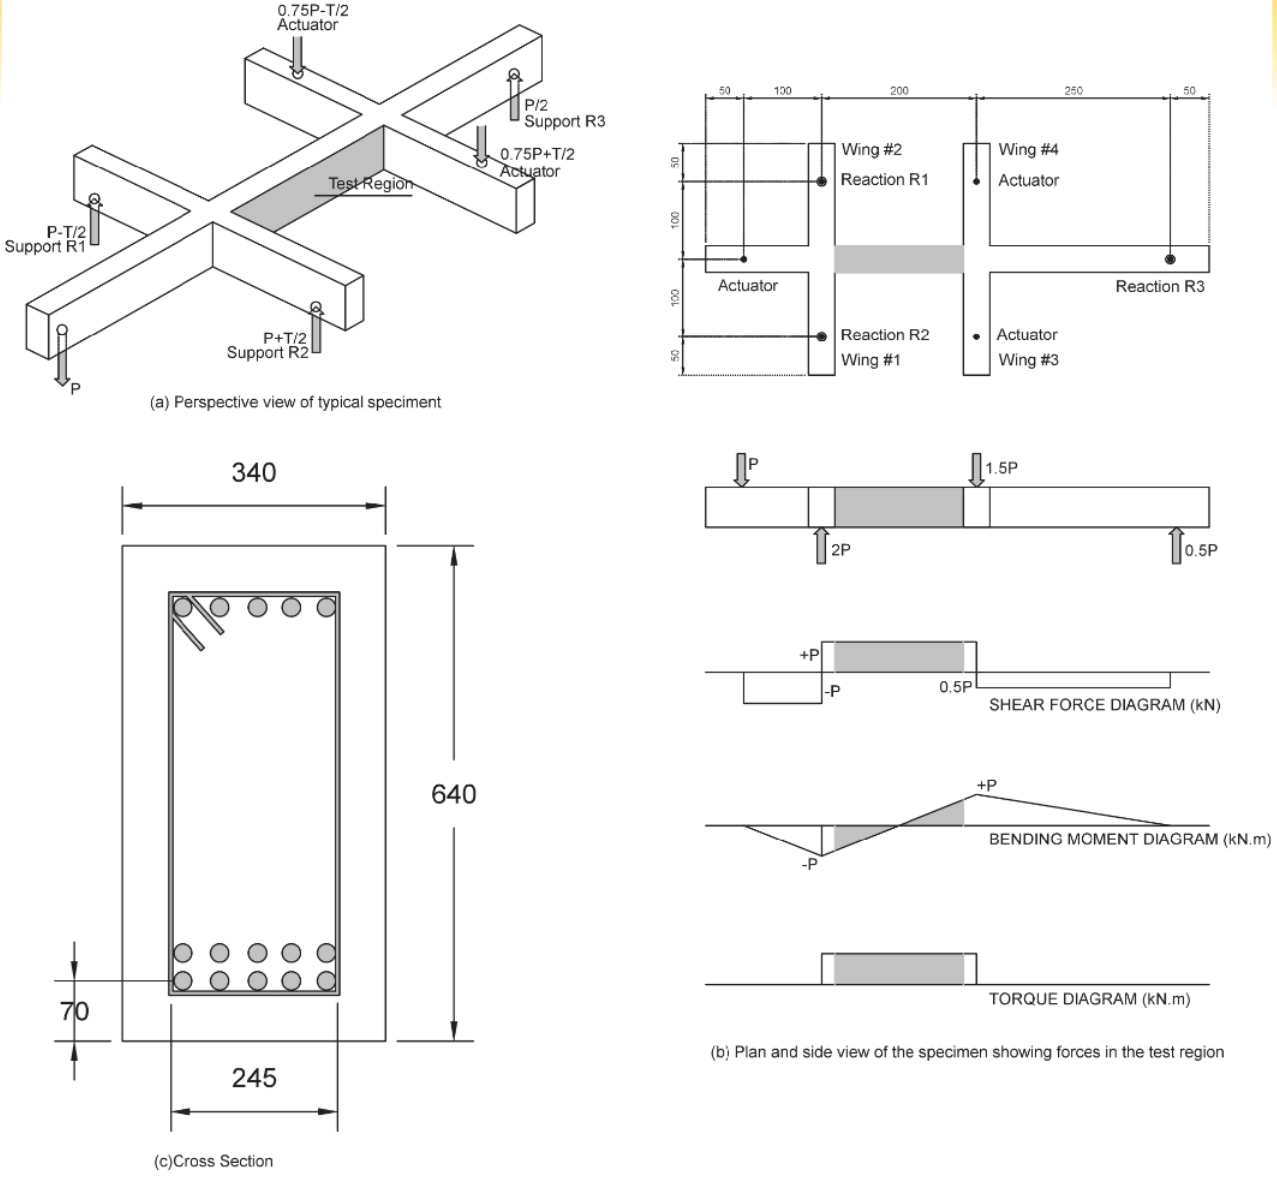
Test details used by Rahal & Collins [3] and also in this The torsional strength (T considering ABNT NBR 6118 or T sd sidering ACI or AASHTO ) when shear is zero , can be calculated using expressions [4] and [6], respectively.